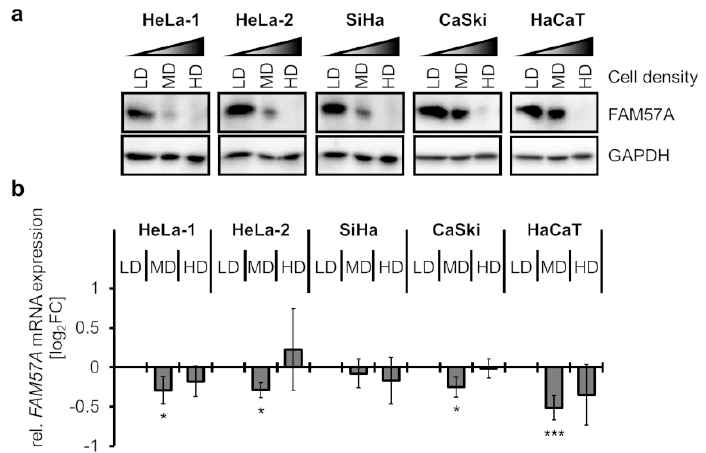
Figure 2. Effects of different cell densities on FAM57A protein and transcript levels. ( a ) Immunoblot analyses of FAM57A protein in cervical cancer cell lines (HeLa-1, HeLa-2, SiHa, CaSki) and HaCaT keratinocytes seeded at low density (LD), medium density (MD), or high density (HD) (please also refer to Figure S4). GAPDH (glyceraldehyde-3-phosphate dehydrogenase), loading control. ( b ) Relative FAM57A mRNA concentrations at different cell densities, as assessed by qRT-PCR. Shown are the log 2 FC of mean FAM57A transcript levels under MD and HD, relative to LD. Standard deviations from at least 3 independent experiments are indicated. Statistically significant differences compared to the respective cell lines at LD (log 2 FC = 0) are determined by one-way ANOVA. *: p < 0.05, ***: p < 0.001.